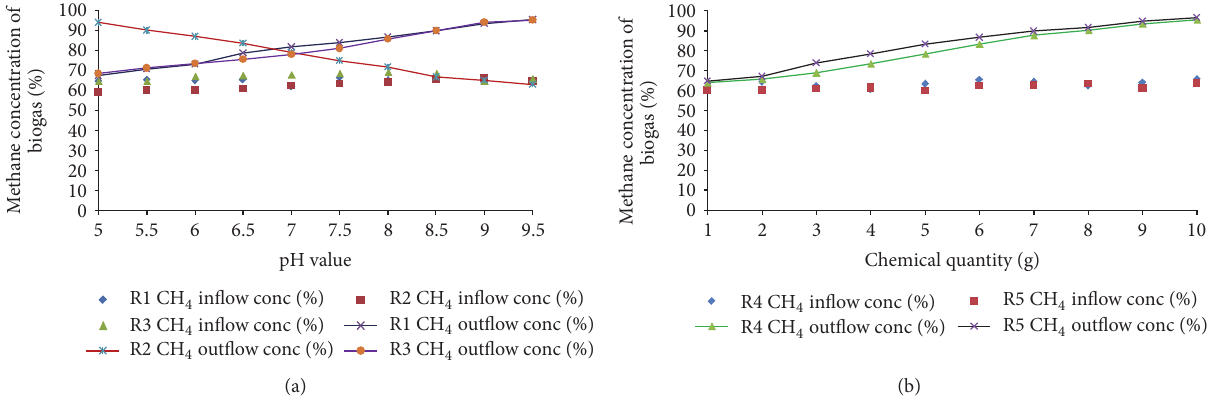
Figure 6: (a) CH 4 inflow versus outflow concentration of biogas under the treatments of runs R1, R2, and R3 and (b) for runs R4 and